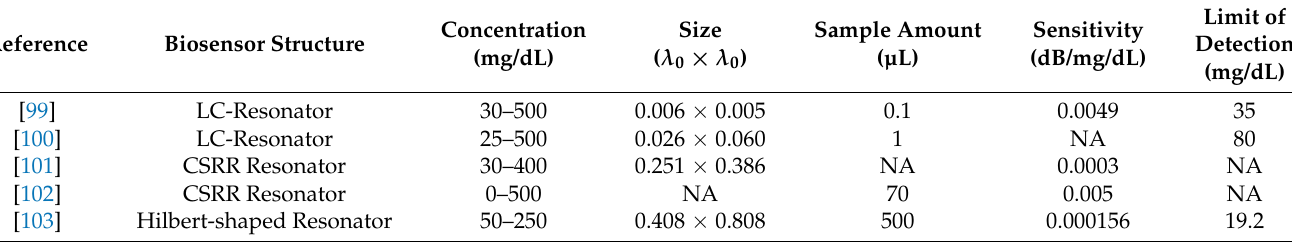
Table 5. Performance comparison of different resonator